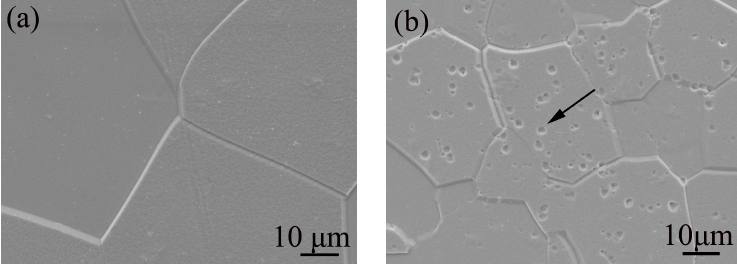
Figure 5. SEM morphologies of microstructures of the alloys after etching: ( a ) alloy C1; ( b ) alloy C2.